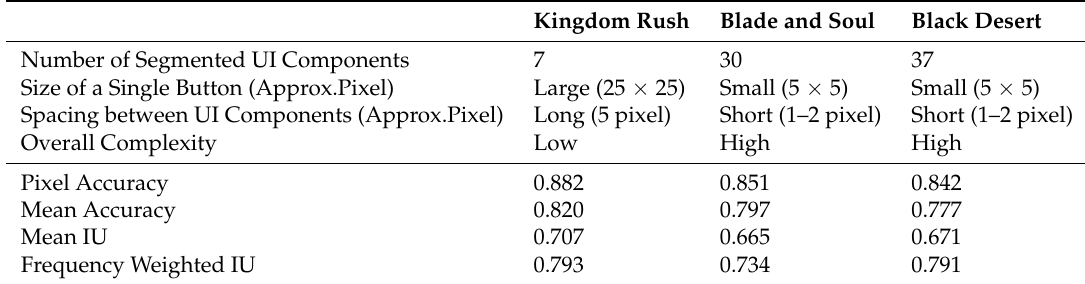
Table 2. Evaluation metric for images produced by the generator for each game. Kingdom